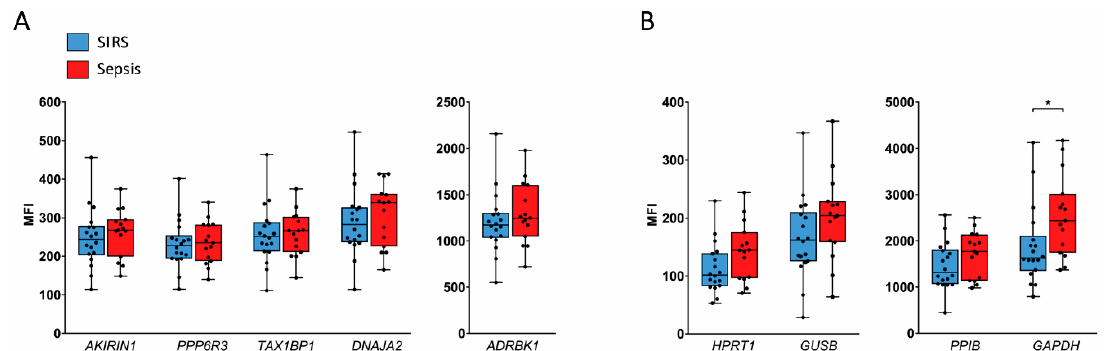
Figure 4. Comparison of candidate reference gene expression in NK cells from the validation set by QGP. Results for candidate reference genes identified from microarray ( A ) and four additional known reference genes ( B ) are grouped by similar signal intensity (MFI) ranges. Data are represented as blue (SIRS, n = 18) and red (sepsis, n = 15) box plots with whiskers from minimum to maximum, median, and dispersion plots. * p < 0.05 from the Wilcoxon rank-sum test.